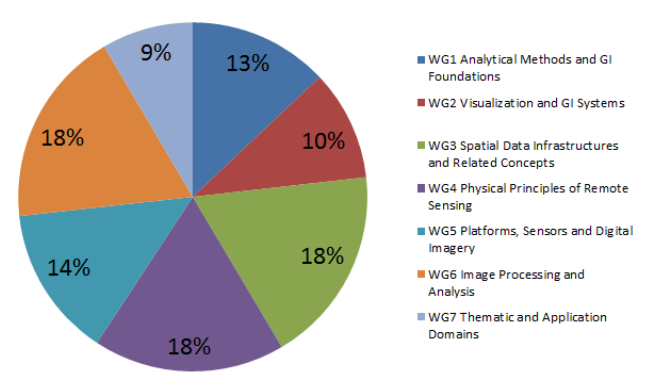
Figure 2. Current distribution of knowledge between the working groups making up EO4GEO